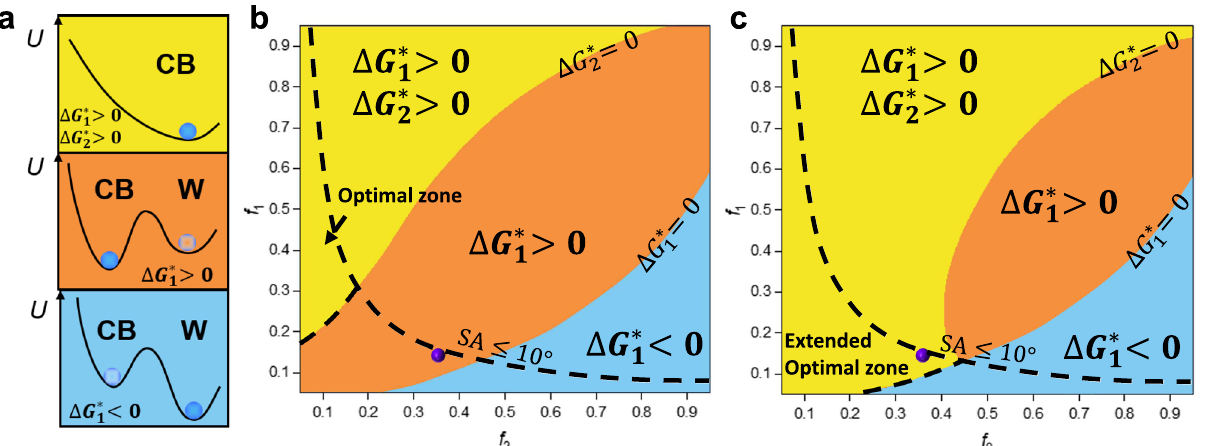
Fig. 7 Theoretical analysis for the energy changes during dewetting transitions. a Three energy states of droplets on different surfaces. b Original phase diagram describing different energy states on surfaces with different micro-nanostructures. Background colors correspond to the distributions of each state, respectively. Yellow denotes the monostable CB zones while orange and blue denote the metastable Wenzel and metastable CB zones, respectively. The black dashed line represents the superhydrophobic conditions, which are described in Supplementary Fig. 15 and Supplementary Discussion 4. The optimal zone for surface design is emphasized by the dashed arrows. The experimental result in this work is marked with the purple point. c Phase diagram after bubbles impacting. It is corresponding to the condition that bubbles contribute to the recovery of 3% of the total air pockets volume ( ε r = 0.03). The extended optimal zone under bubbles impact is emphasized. It can be observed that the droplets on the MCNP surface become the monostable CB state under bubbles